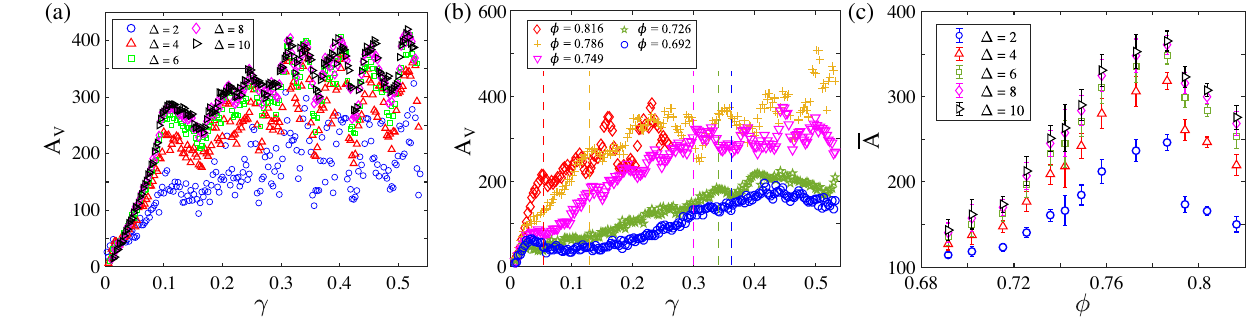
Figure 3. (a) Area of regions with absolute vorticity greater than the threshold, A V , for various ∆ as a function of shear strain γ at packing fraction φ = 0 . 794. (b) A V vs. γ for various φ with ∆ = 6. Dashed lines correspond to the onset γ at which A V reaches a plateau. 1 (c) Area plateau value ¯ A as a function of φ for various ∆ indicated by the symbols. Areas are in units of ¯ D 2 .